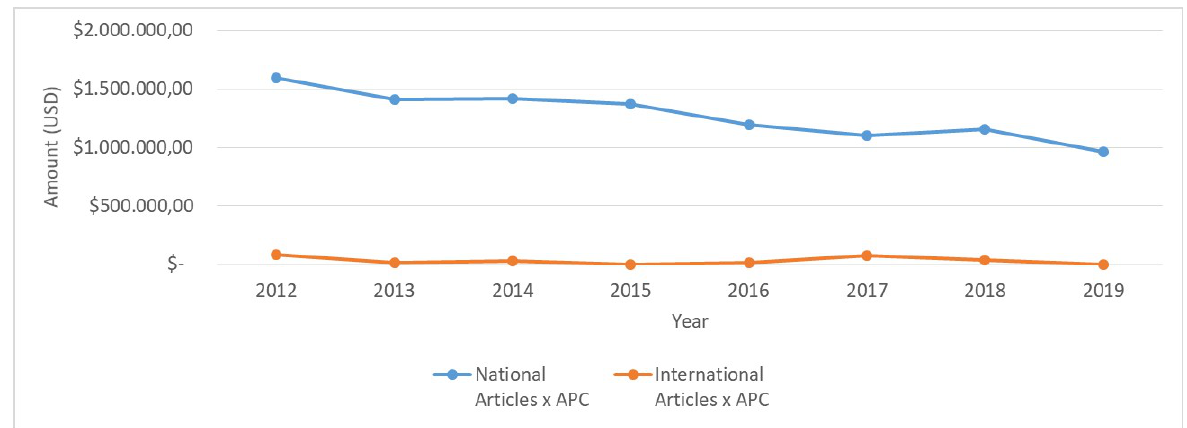
Figure 6. Total spending on publication APCs in journals maintained by national and international non-profit publishers. (Source: the authors).